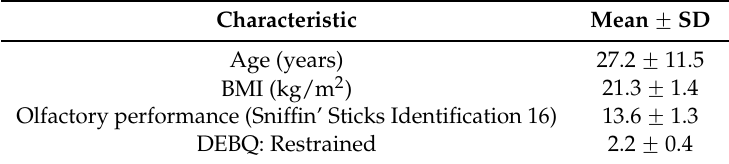
Table 1. Population ( N = 29) description by demographic and personality